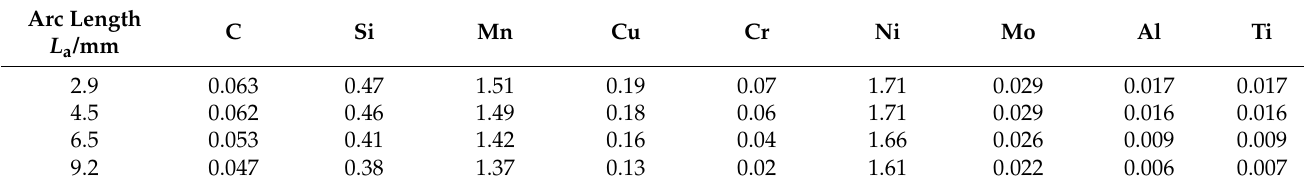
Table 3. Chemical composition of weld metal under different arc lengths (wt.%).